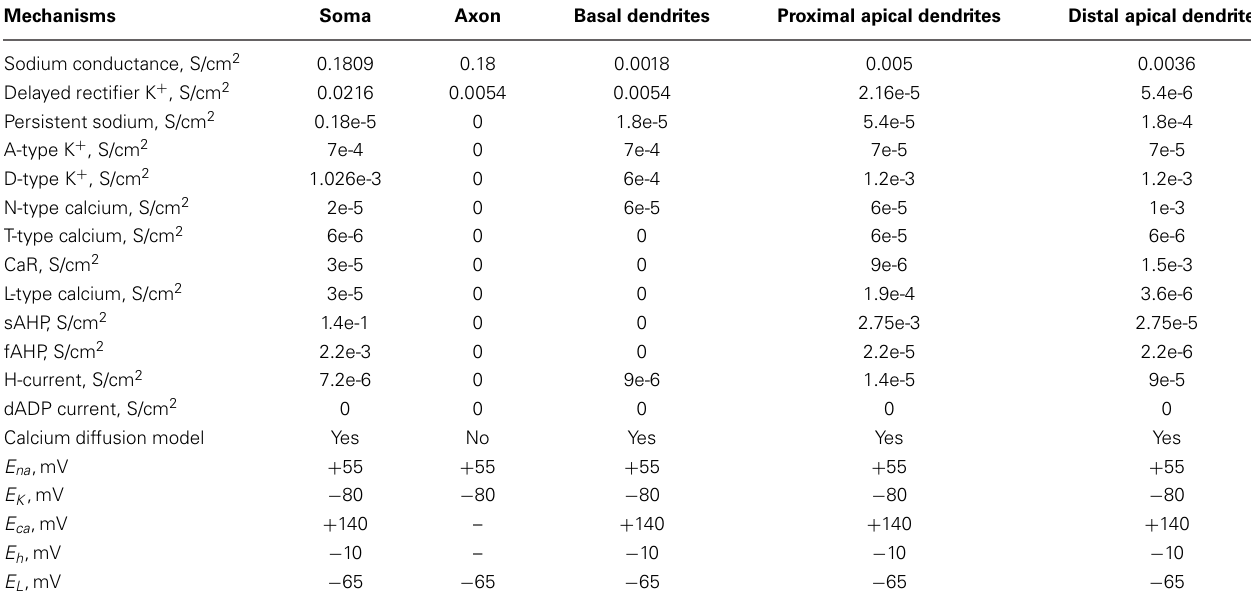
Table 3 | Active ionic properties of pyramidal neurons. Mechanisms Soma